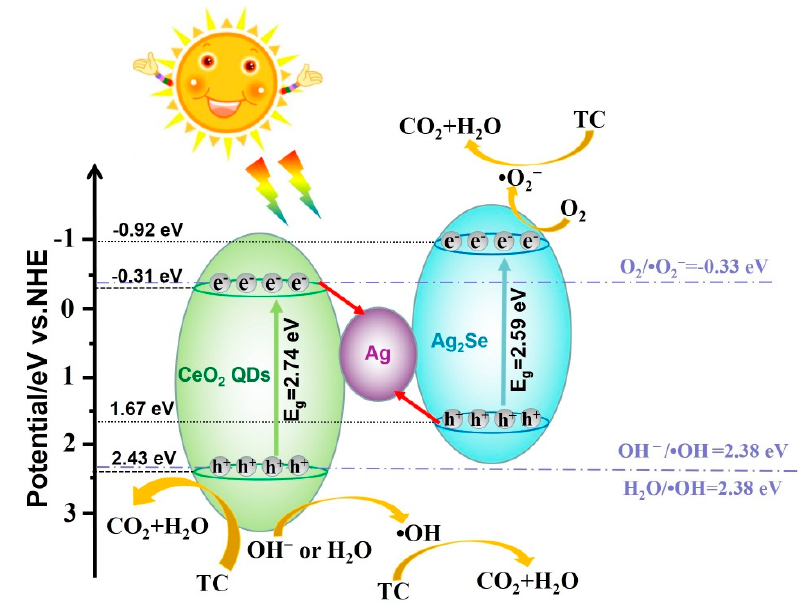
Scheme 1. Schematic illustration of electron transfer and active radical synthesis of the CeO 2 QDs / Ag 2 Se Z-scheme nano-heterojunction under visible light illumination.